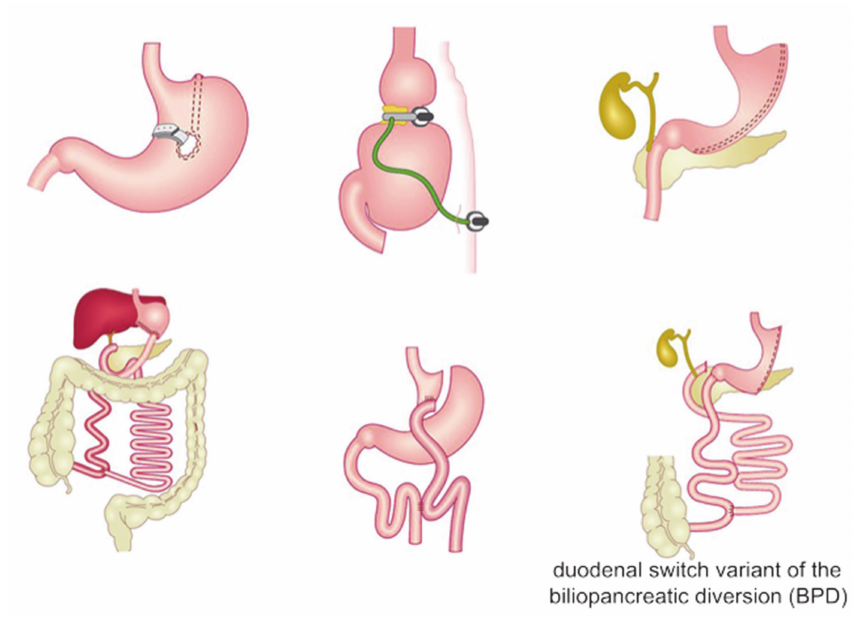
Figure 1. Description of the main types of bariatric surgery procedures. Figure was adapted from https://siceitalia.com/chirurgia-dellobesita accessed on 29 July 2021 (Italian Society of Endocrine